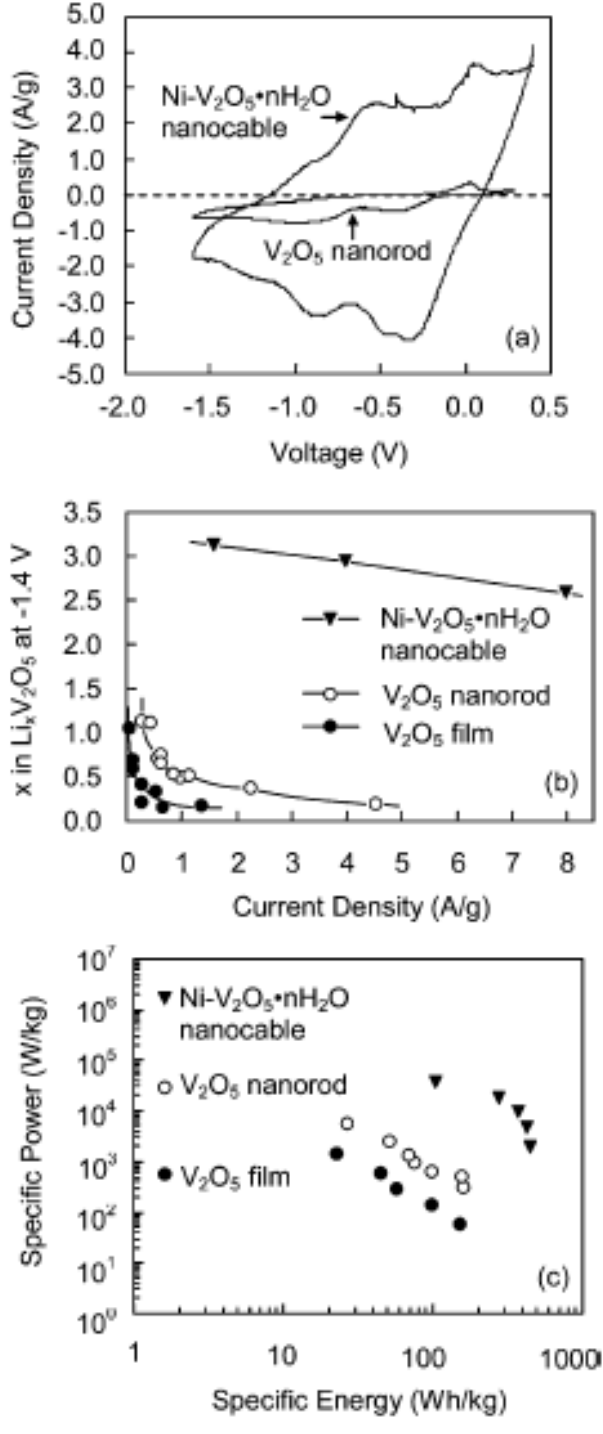
Figure 7. (a) Cyclic voltammograms of Ni-V array using a scan rate of 10 mV/s. (b) Relationship between current density and Li intercalation capacity of Ni-V film from chronopotentiometric measurements. (c) Ragone plot for Ni-V nanocable array, V 2005 American Chemical